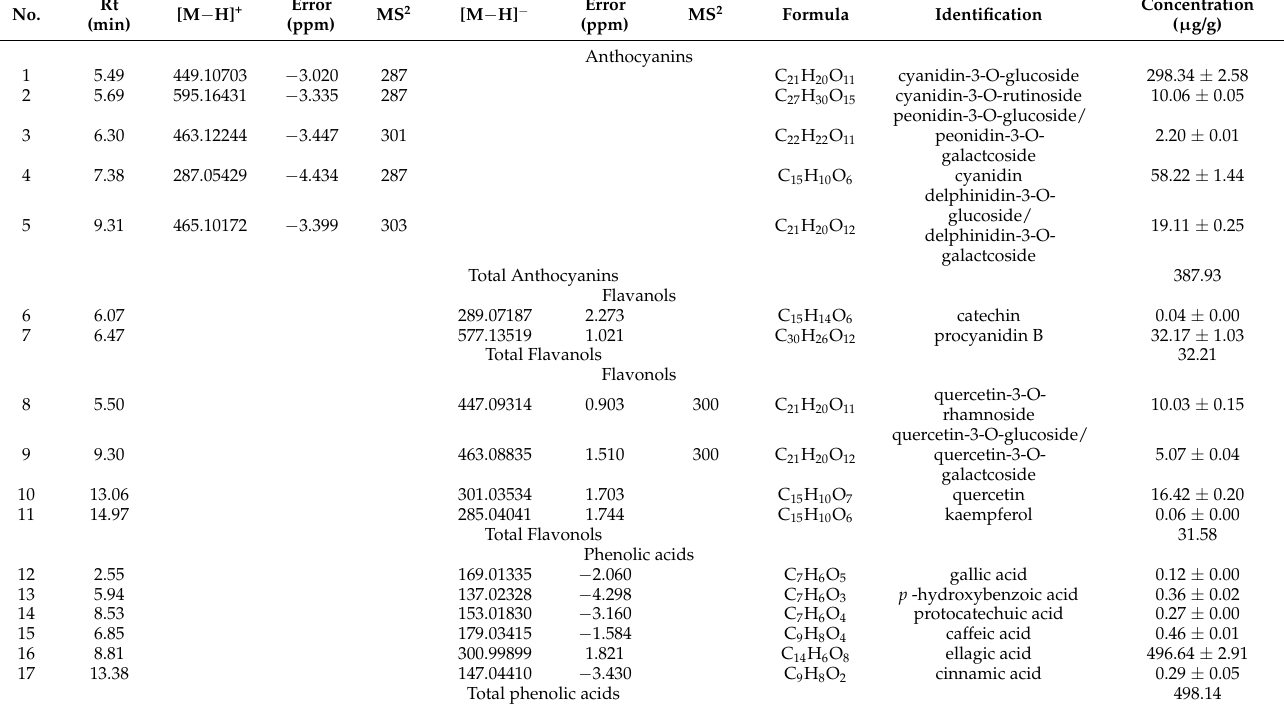
Table 1. Phenolic composition in FRJ.